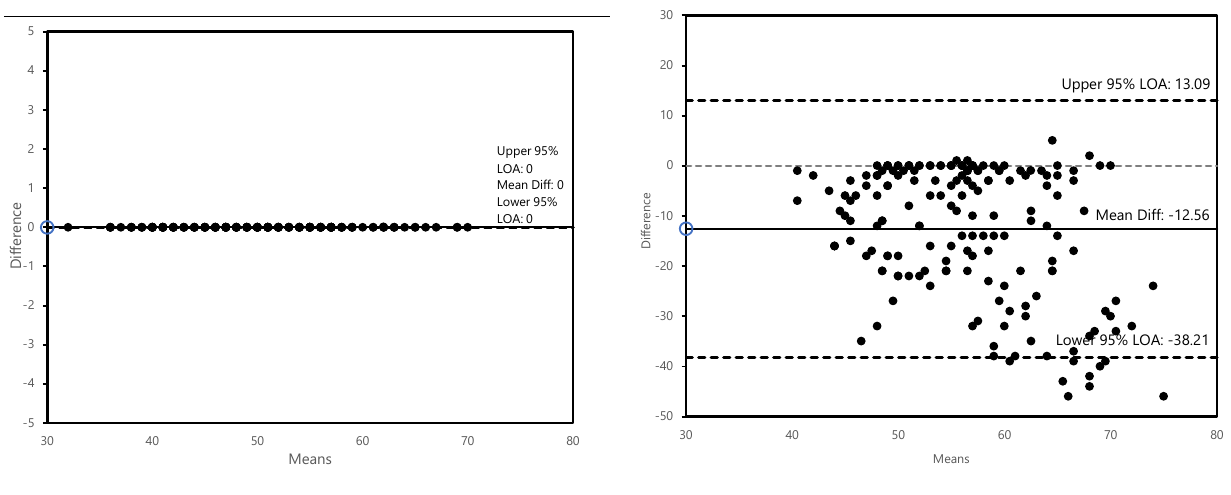
Figure 5 . Bland-Altman Plot for the Wrist ActiGraph Accelerometer. Positive Y-axis Values Indicate ActiGraph Wrist Push Counts that Were Less Than Manual Push Counts and